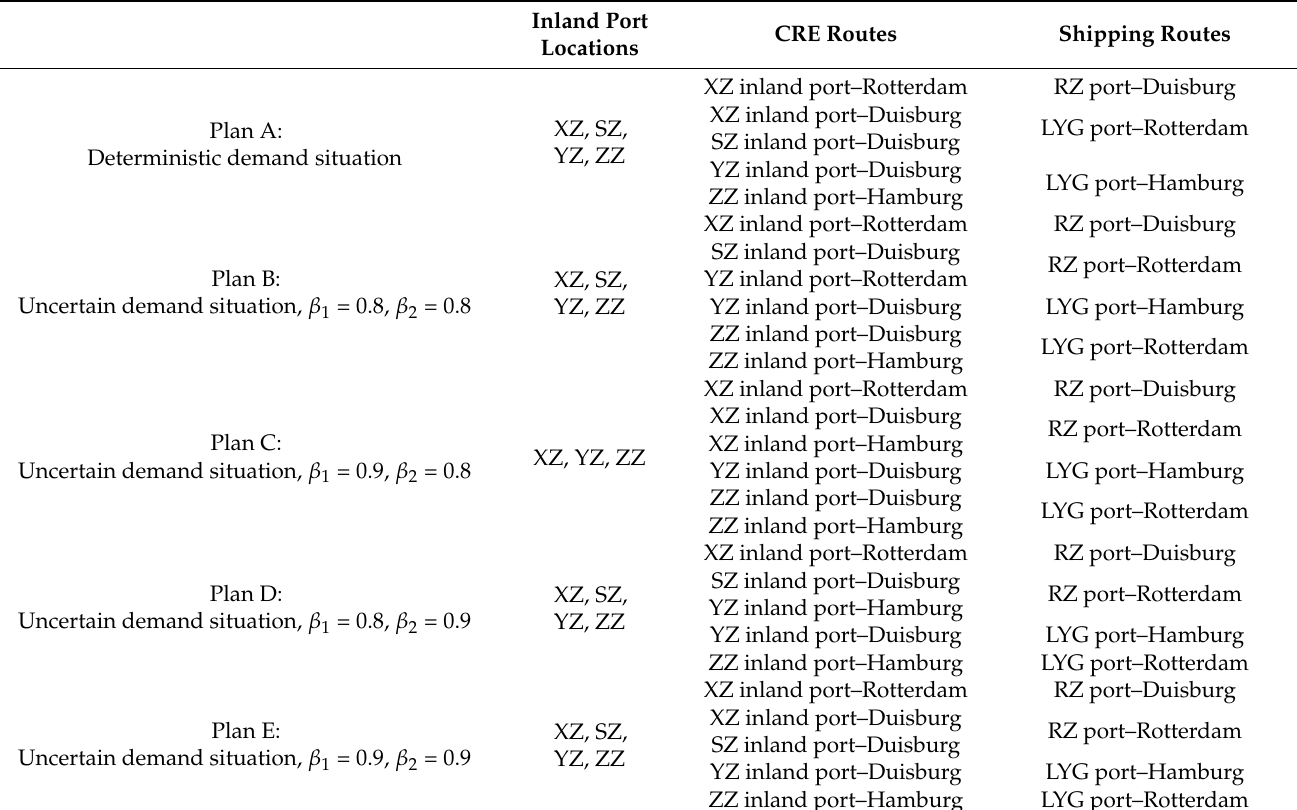
Table 5. Computational results in Plan A to Plan E.